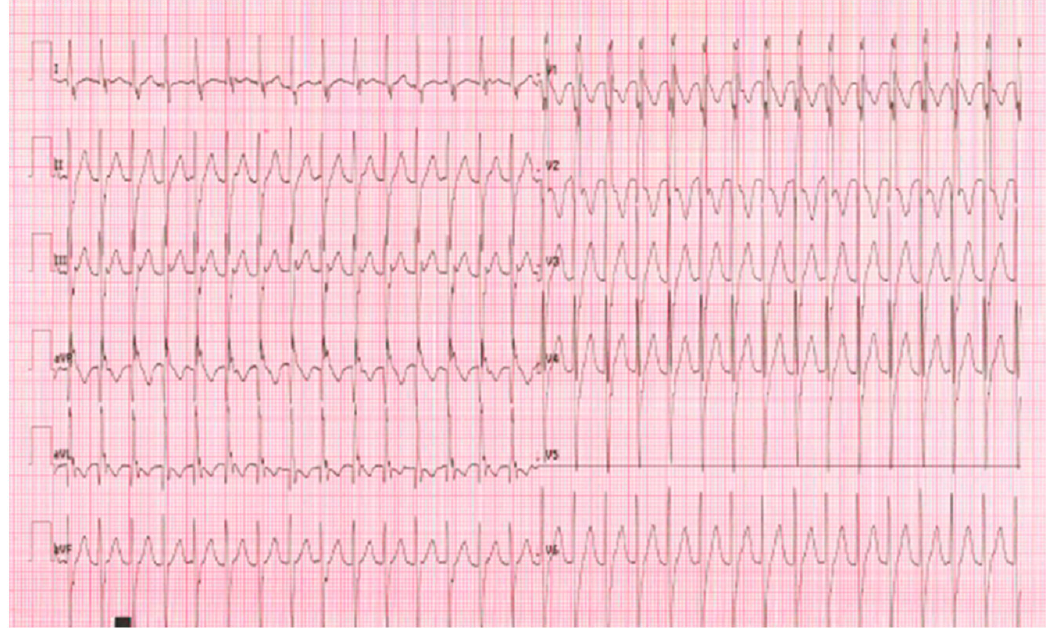
Figure 1. Posterior left fascicular tachycardia (left axis deviation with RBBB).